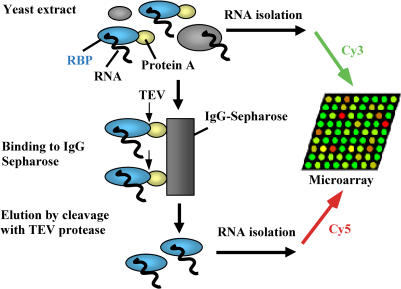
Strategy for Analyzing Genome-Wide RNA–Protein InteractionsProtein A-tagged Puf proteins were captured with IgG–Sepharose and released from the beads by cleavage with TEV protease. RNAs associated with the released proteins were isolated, and cDNA copies were fluorescently labeled and hybridized to yeast DNA microarrays. The Cy5/Cy3 fluorescence ratio for each locus reflects its enrichment by affinity for the cognate protein.